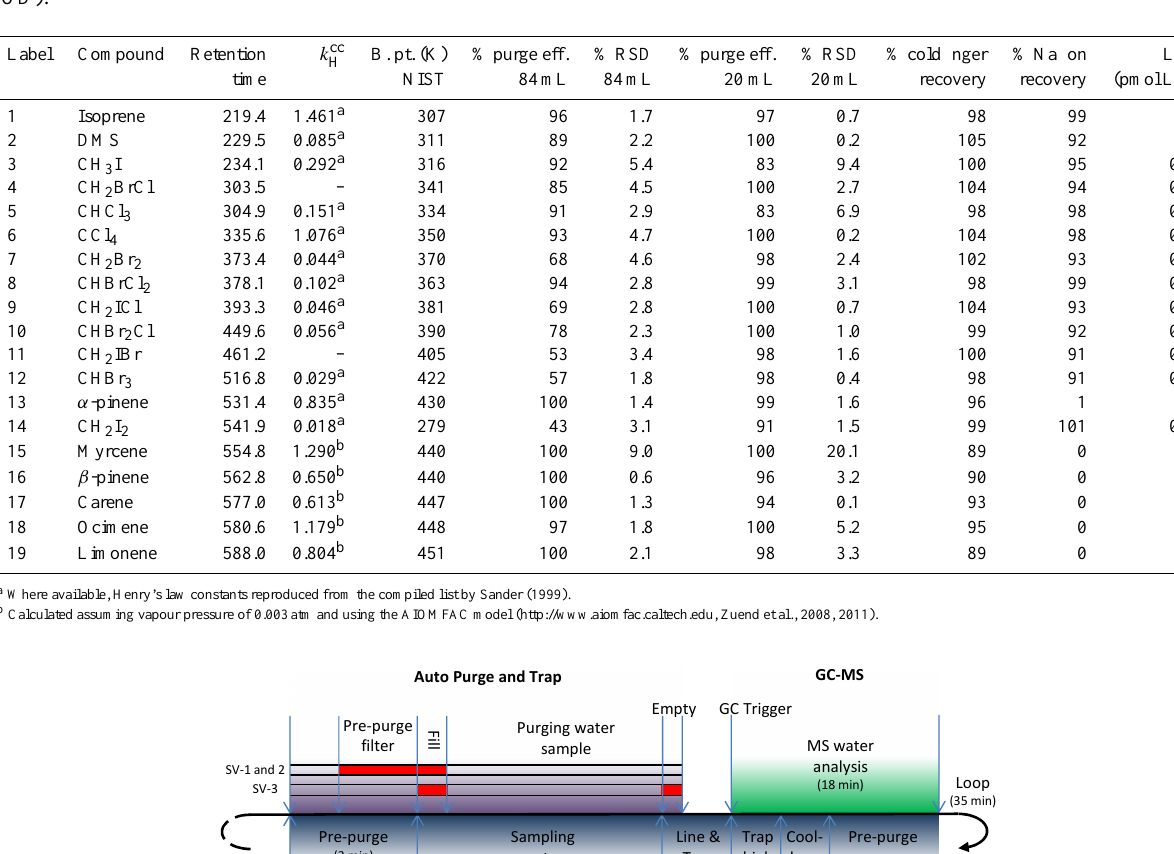
Table 1. Individual compound purge efficiencies using AutoP&T, associated data, water removal analyte recoveries and limits of detection (LOD).